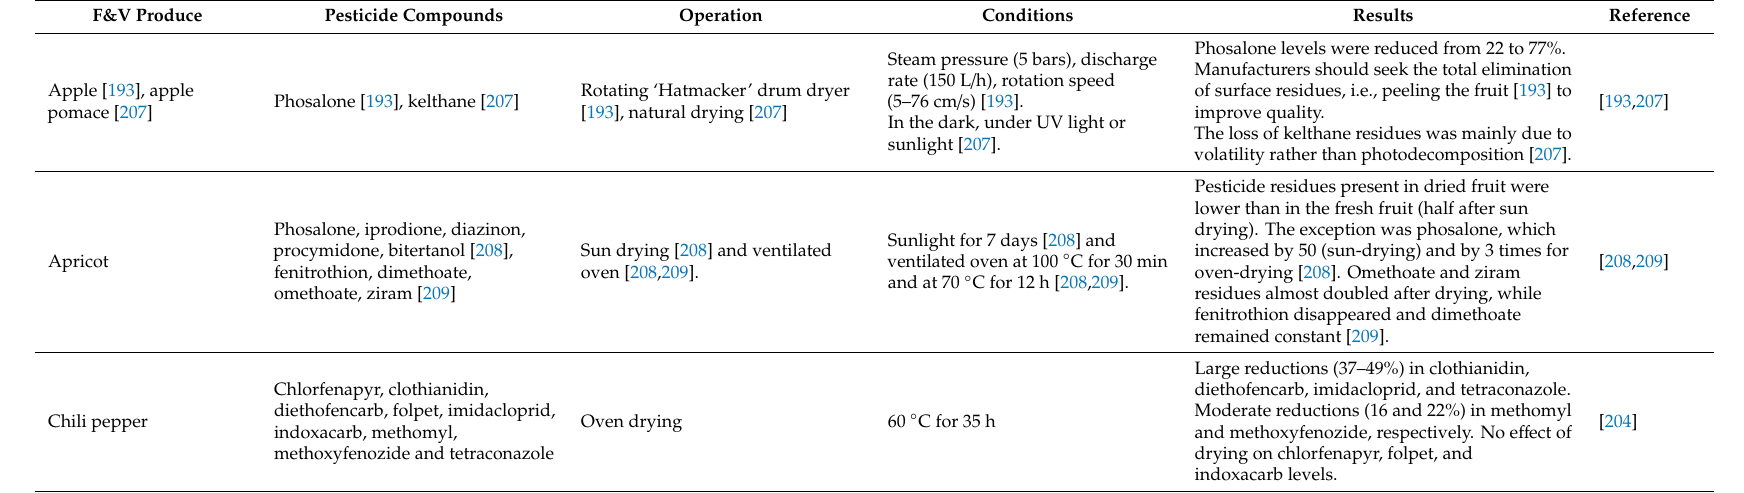
Table 6. E ff ect of drying methods on residual pesticides in fruits and